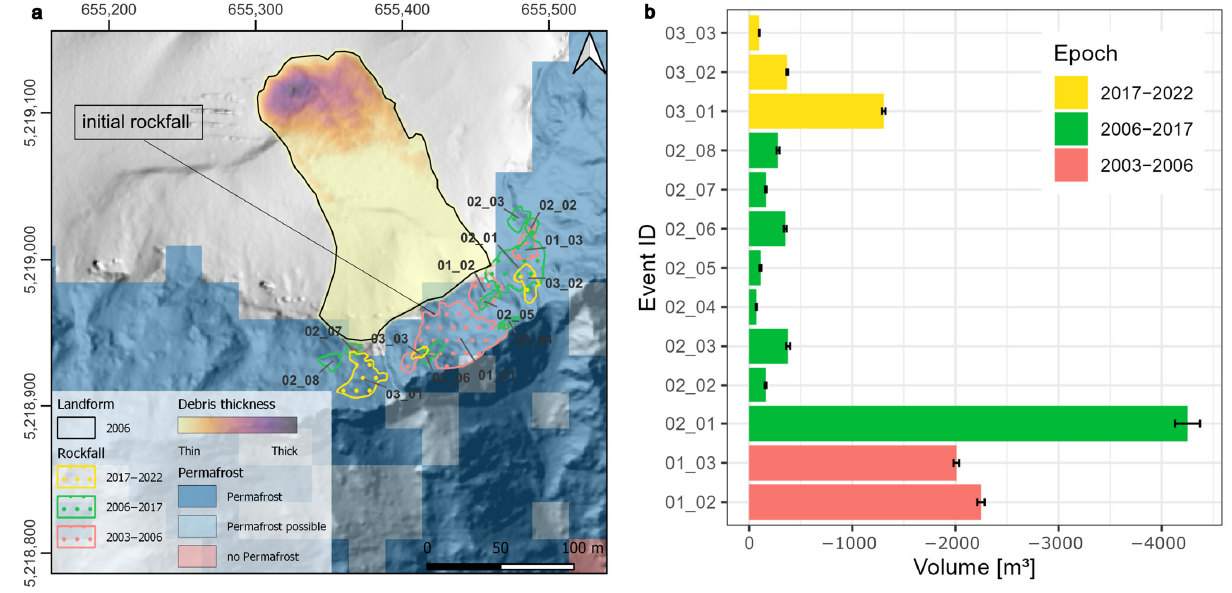
Figure 2. ( a ) Rockfall detachment areas, which are mapped based on DoDs, modeled permafrost occurrence following the approach of Kenner et al. [57] and estimated debris thickness after the initial rockfall. ( b ) Volume of rockfalls calculated based on DoDs. The initial rockfall, which has a volume of 19,267 m 3 ± 204 m 3 , is not plotted.